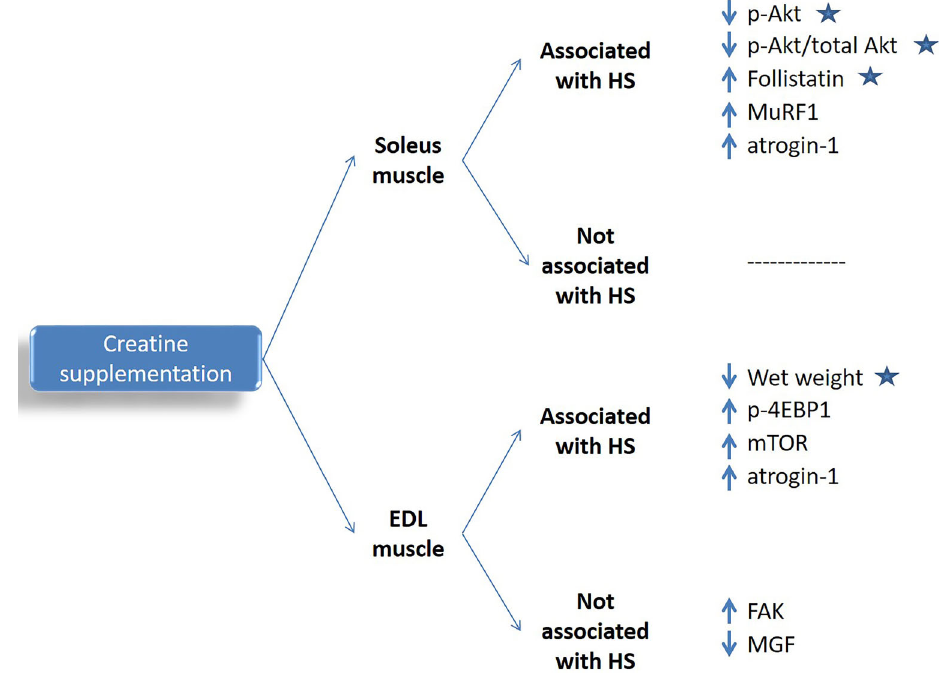
Figure 5. Main results observed in this study. Signi fi cant effects not associated with HS were observed in creatine supplemented animals only. EDL: extensor digitorum longus; HS: hindlimb suspension; p-Akt: phospo-protein kinase B content; MuRF1: muscle RING- Finger protein-1 expression; atrogin -1: muscle-speci fi c F-box protein expression; p-4EBP1: eukaryotic translation initiation factor 4E (eIF4E) binding protein 1 content; mTOR : mammalian target of rapamycin expression; FAK : focal adhesion kinase expression; MGF : mechano growth factor expression; Stars indicate factors attenuated by creatine supplementation compared with the placebo